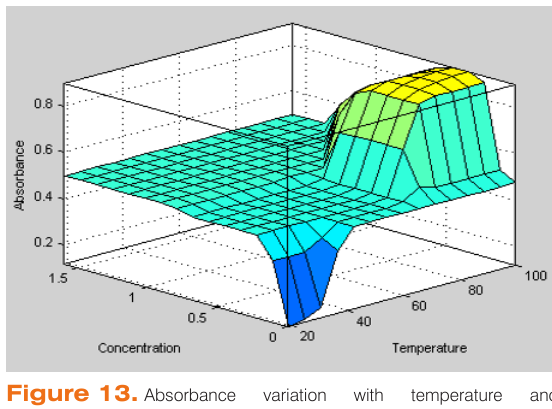
Figure 12. Fuzzy inference system.